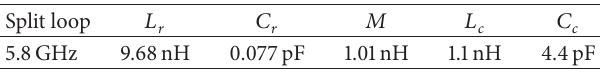
Table 2: Calculated result of elements for equivalent circuit in Figure 8.